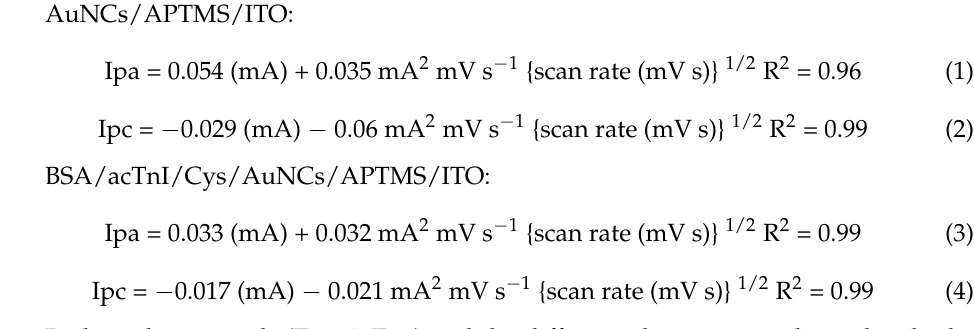
Figure 4. Cyclic voltammetry of ( a ) AuNCs/APTMS/ITO and ( b ) BSA/acTnI/Cys/AuNCs/APTMS/ITO and inset of ( a ) and ( b ) show the calibration plot of Ipa and Ipc with a scan rate of 10–100 mV/s.